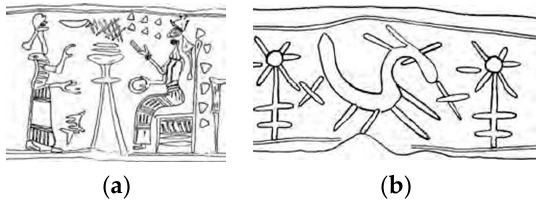
Figure 10. Seals with astral symbolism: ( a